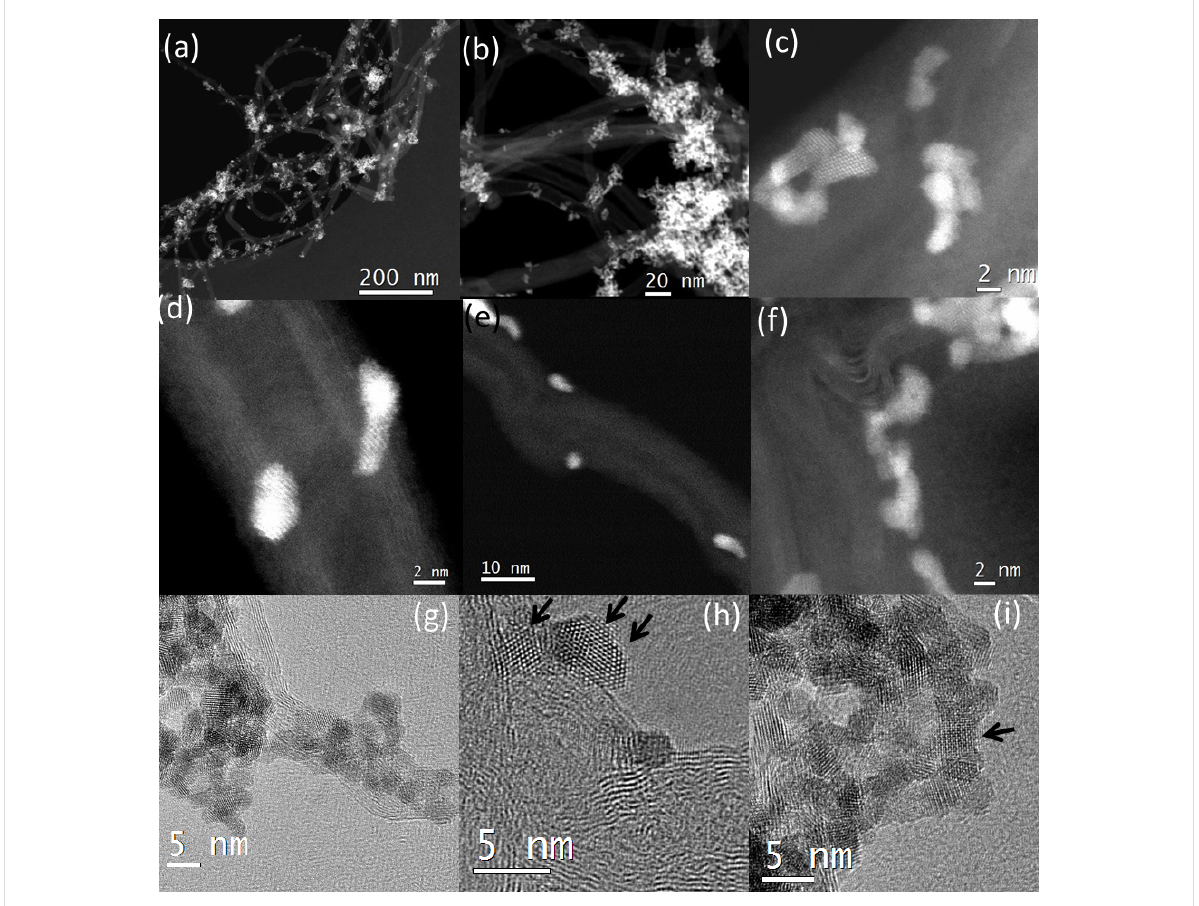
Figure 1: (a) HAADF-STEM image of the MWCNT:HfO 2 , (b) higher magnification image of (a), (c) HAADF-HRSTEM images of the HfO 2 NPs on the MWCNTs, (d) NPs attached to the side walls of a MWCNT, (e) NPs attached at buckled edges of the MWCNT, (f) wall of the nanotube showing defects and irregularities to which nanoparticles are attached, (g) HRTEM images of randomly oriented agglomerates, (h) <110>-oriented, and (i) <001>-oriented nanoparticles indicated by arrows and all attached to curved regions of the CNT.